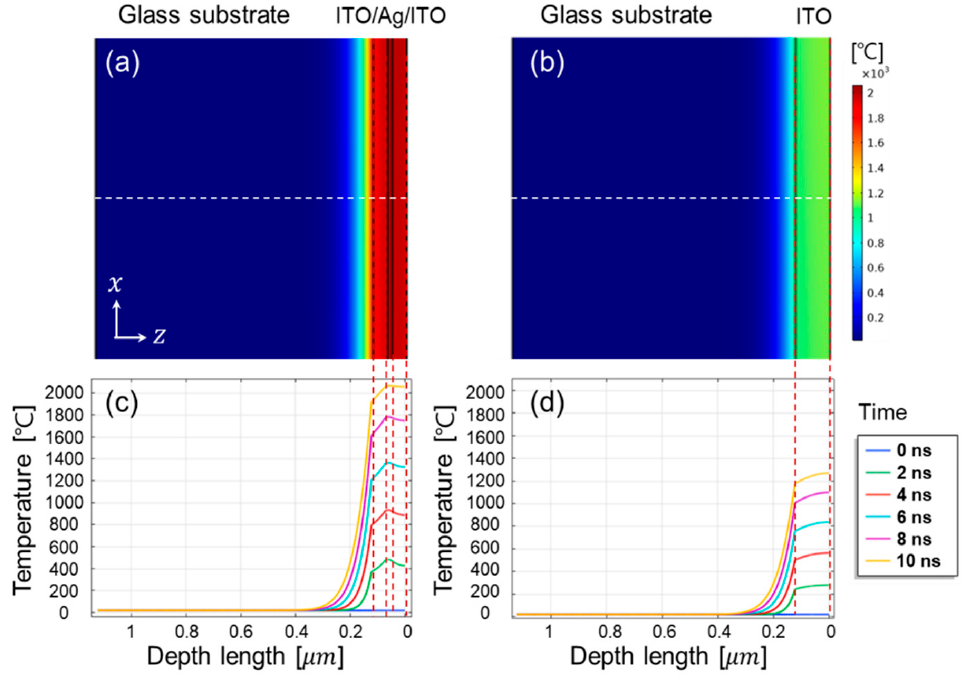
Figure 9. Transient temperature analysis in XZ-plane of ITO (53 nm)/Ag (16 nm)/ITO (53 nm) on 1 µ m thick glass substrate ( a , c ) and of ITO SL on the same glass substrate ( b , d ). Laser irradiation ( λ , 1064 nm) in single pulse (duration of 10 ns) of energy fluence 0.39 J/cm 2 .